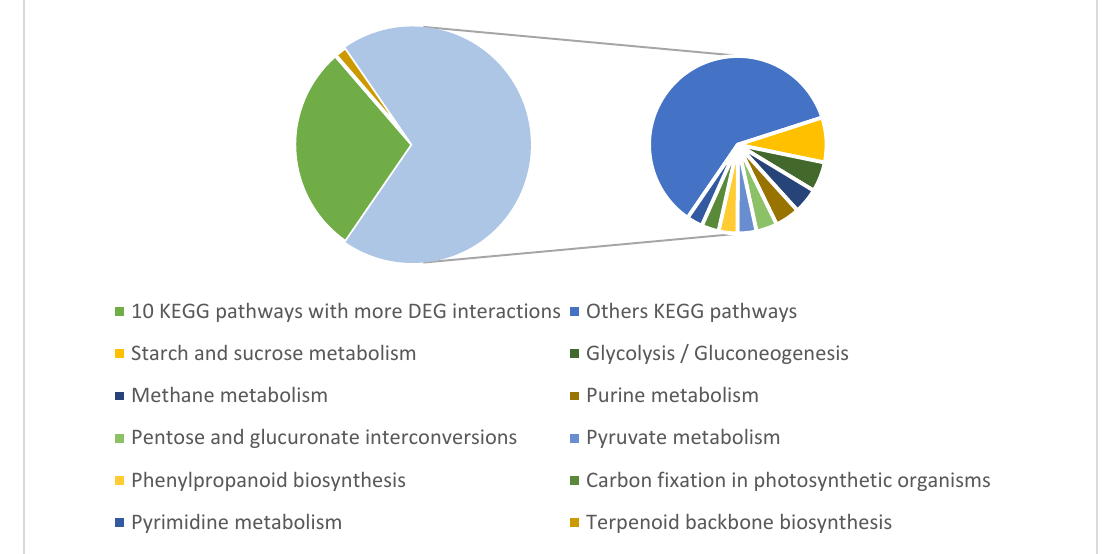
Figure 5. Representation of the KEGG pathways with more DEG interactions. Left pie chart displays the total differential expressed gene (DEG) interactions over the 94 different KEGG pathways, while, the secondary pie chart ranks the 10 pathways with more DEG interactions.